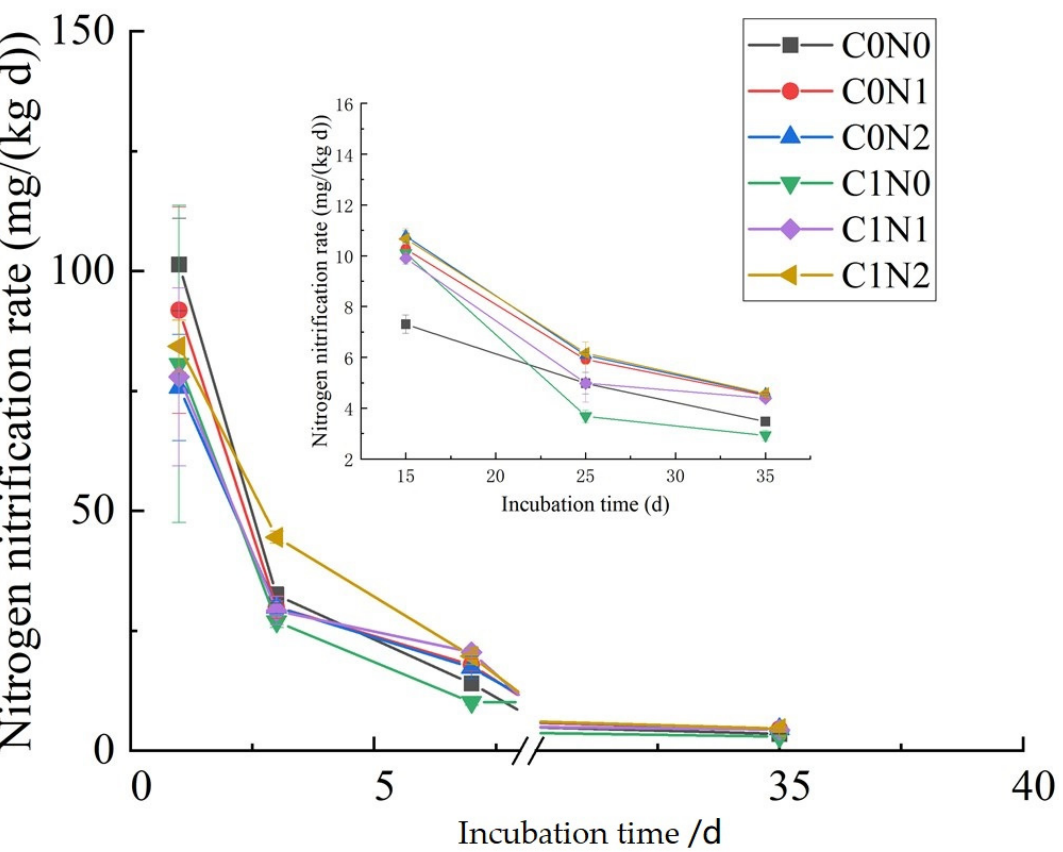
Figure 2. Dynamic changes in the nitrification rate of nitrogen in saline soil during incubation.